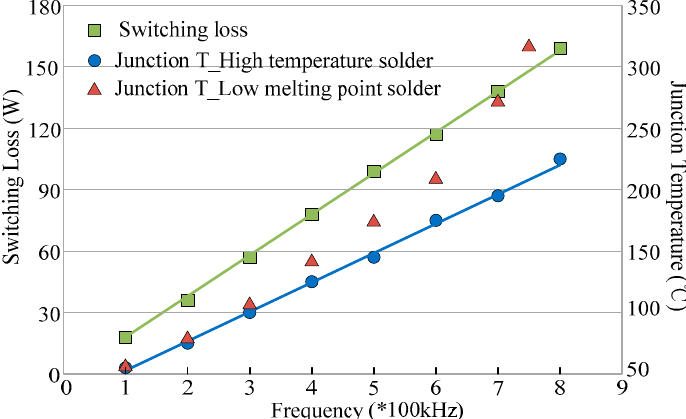
Figure 15. Switching loss and junction temperature distribution diagram under different frequencies.